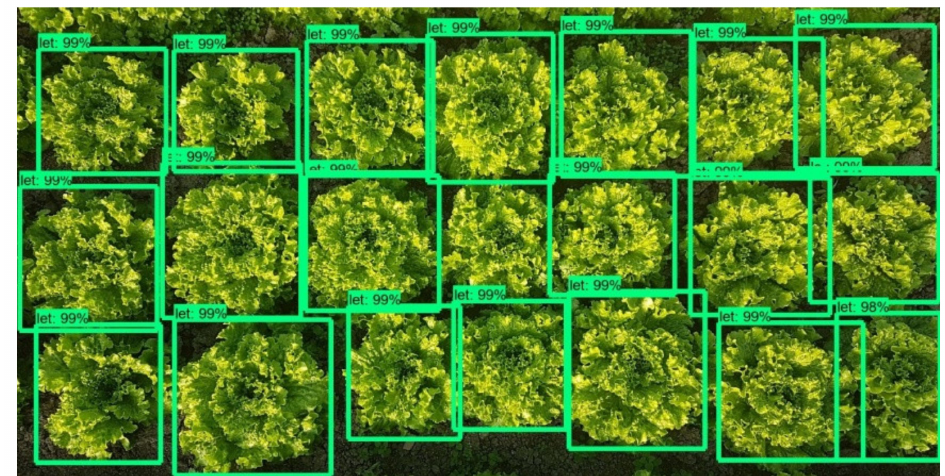
Figure 18. Plant detection and localization example in lettuce plants of advanced growth stages. All lettuces are successfully